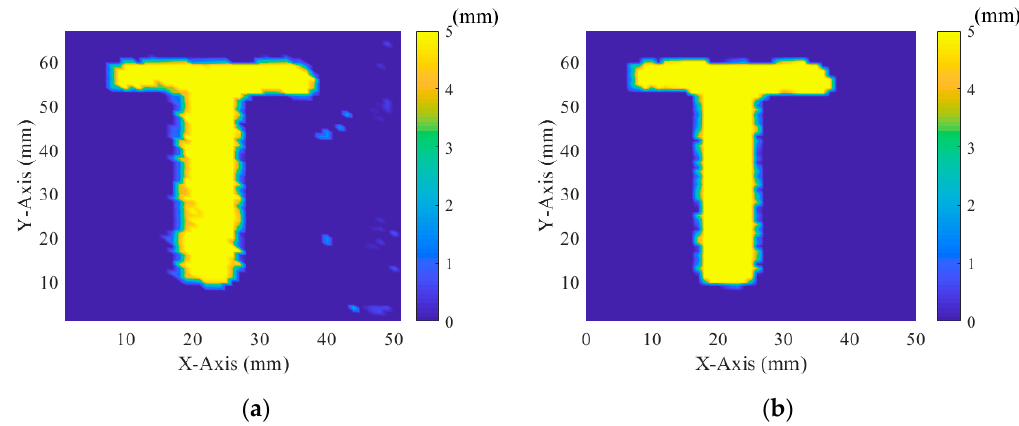
Figure 14. Imaging results of the “T” imaging target: ( a ) imaging result before the imaging process; ( b ) imaging result after the imaging process.